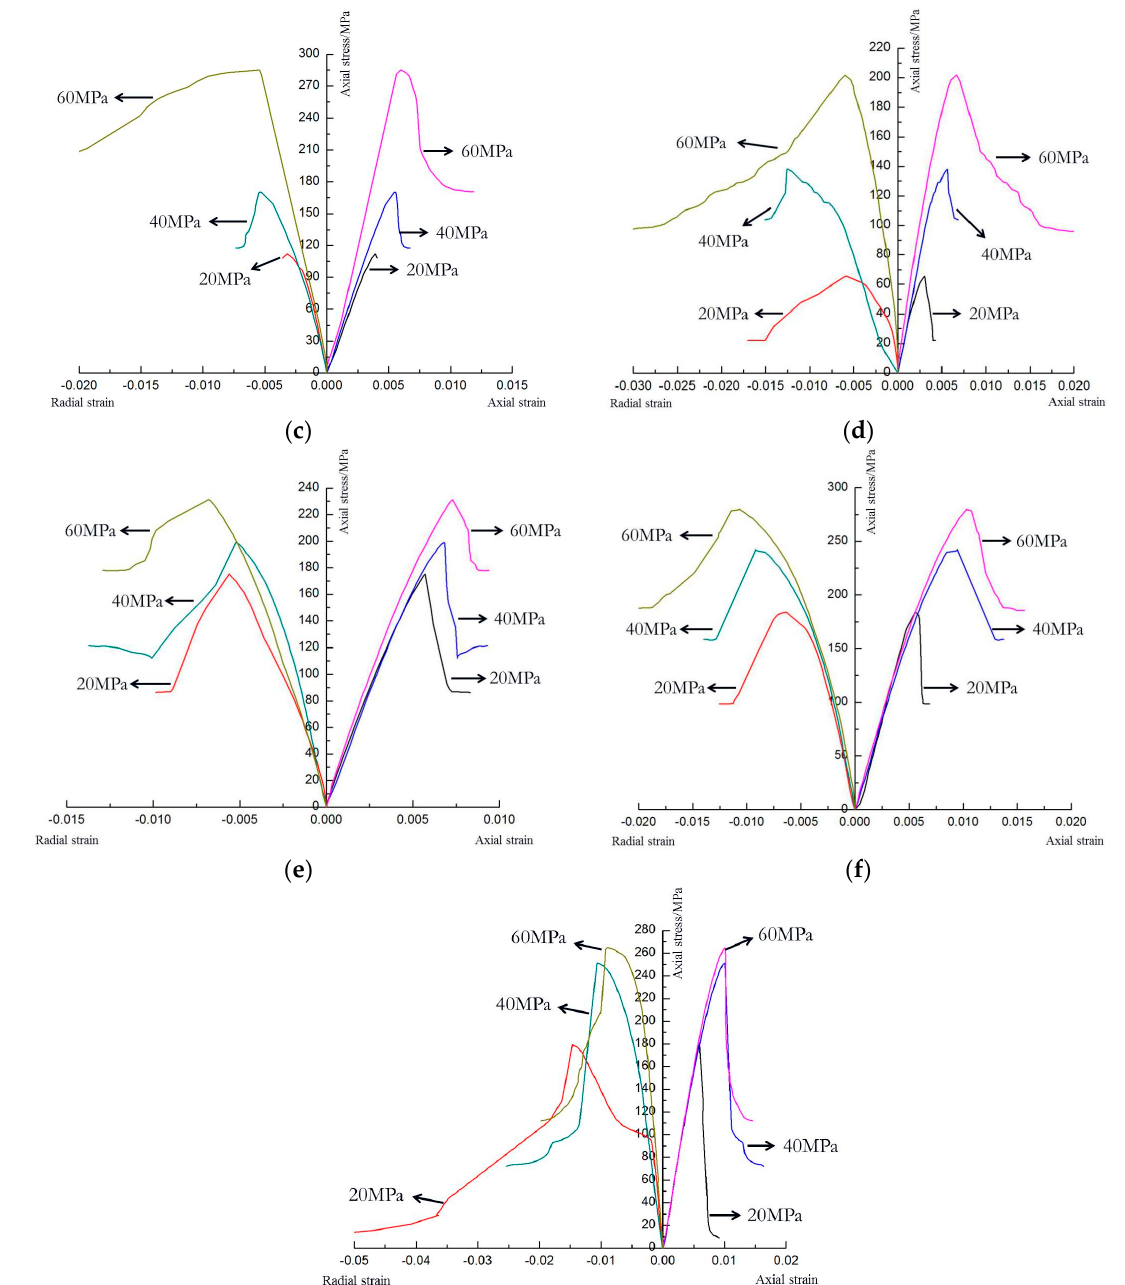
Figure 7. Stress-strain curves for shale subject to triaxial compression corresponding to: ( a ) 0°; ( b ) 15°; ( c ) 30°; ( d ) 45°; ( e ) 60°; ( f ) 75°; and ( g ) 90°, respectively.